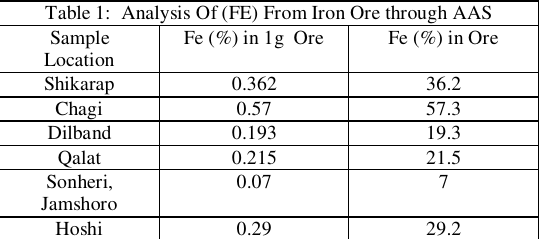
Table 1: Analysis Of (FE) From Iron Ore through AAS Sample Location